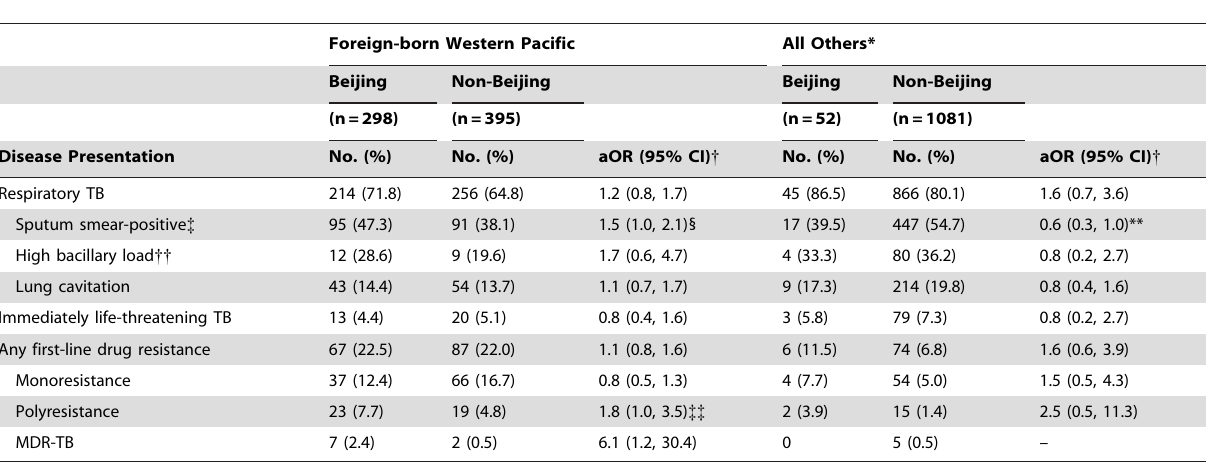
Table 3. Association between M. tuberculosis lineage and disease presentation based on population group.